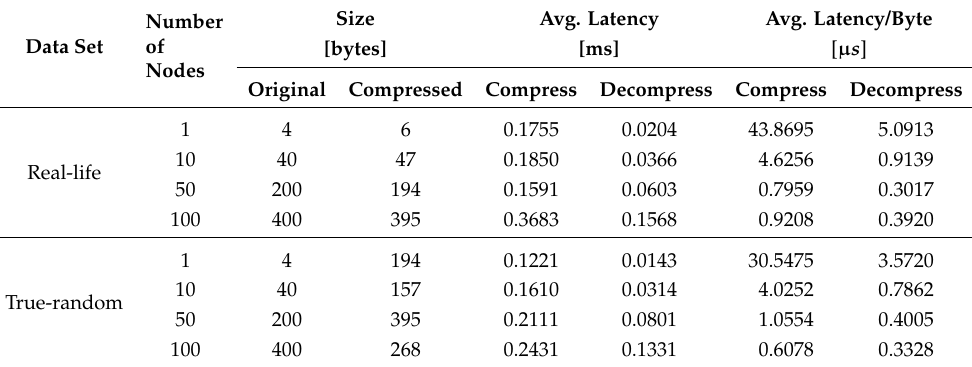
Table 3. LZW compression and decompression latency on edge and LoRa gateway, respectively, in different configuration